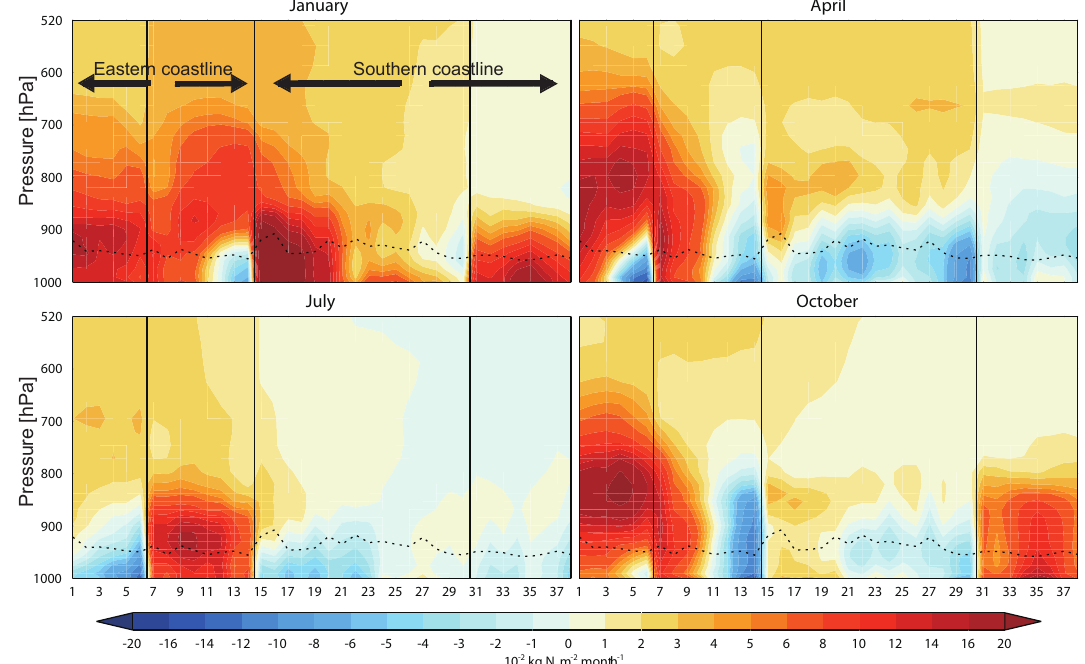
) transported from the mainland of , HNO 3 , isoprene nitrates, and NO − 4 3